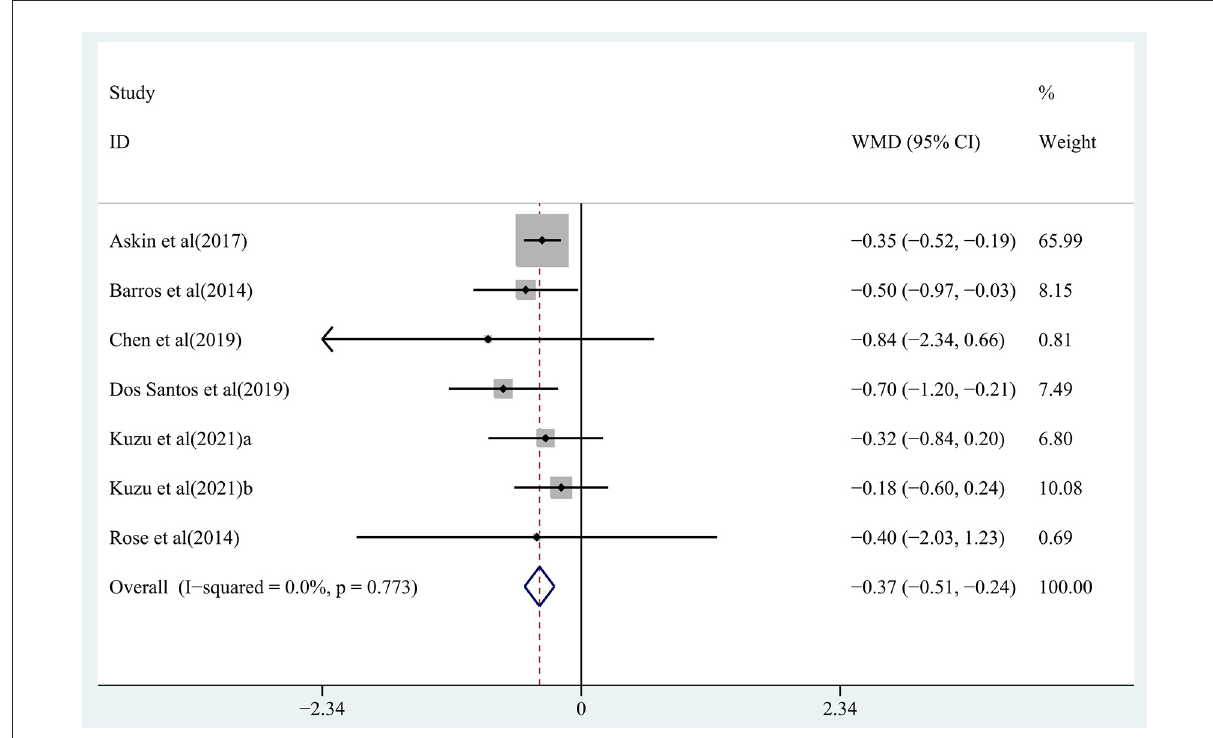
FIGURE5 Forest plot of the effect of rTMS treatment on muscle tone reduction in chronic stroke